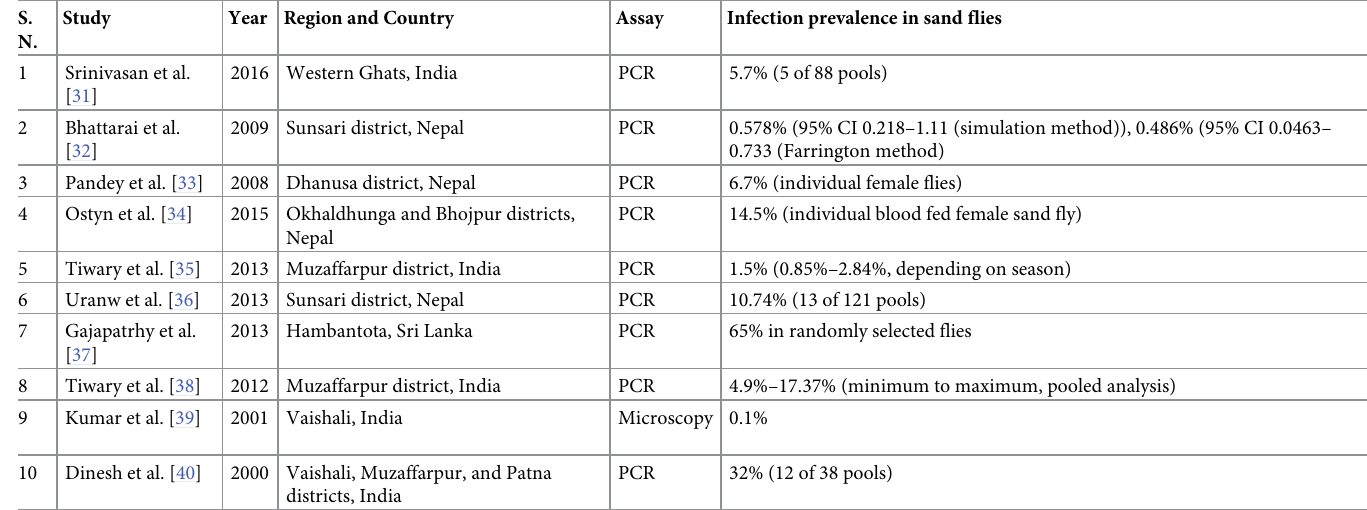
Table 1. Studies on the Indian subcontinent estimating proportion of Leishmania donovani– infected Phlebotomous argentipes population. S. N.